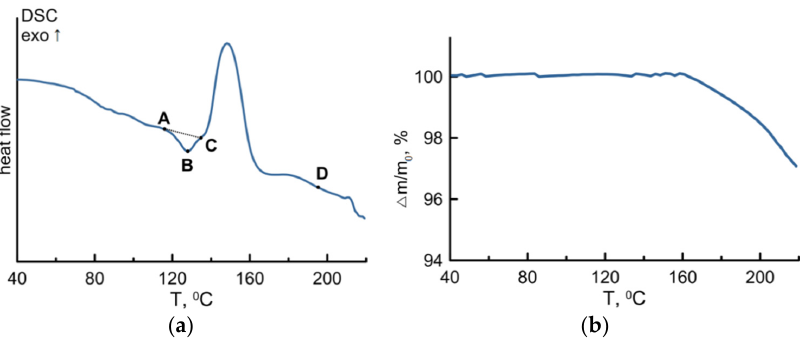
Figure 4. DSC ( a ) and TG ( b ) measurements of the Cd(C 12 H 25 S) 2 /PMMA sample in an argon atmosphere.